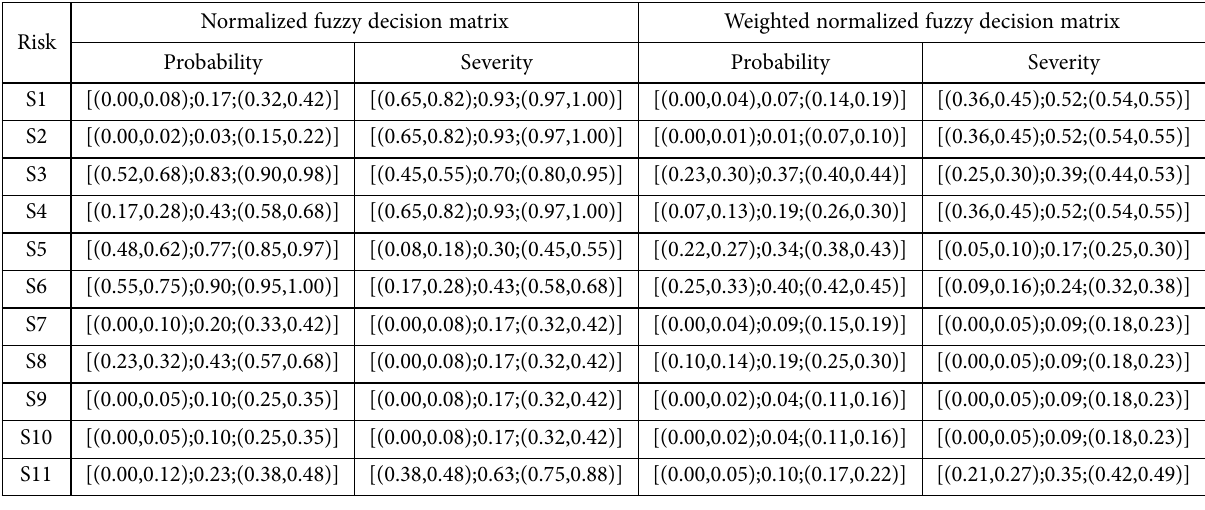
Table 6. Normalized fuzzy decision matrix and weighted normalized fuzzy decision matrix Risk